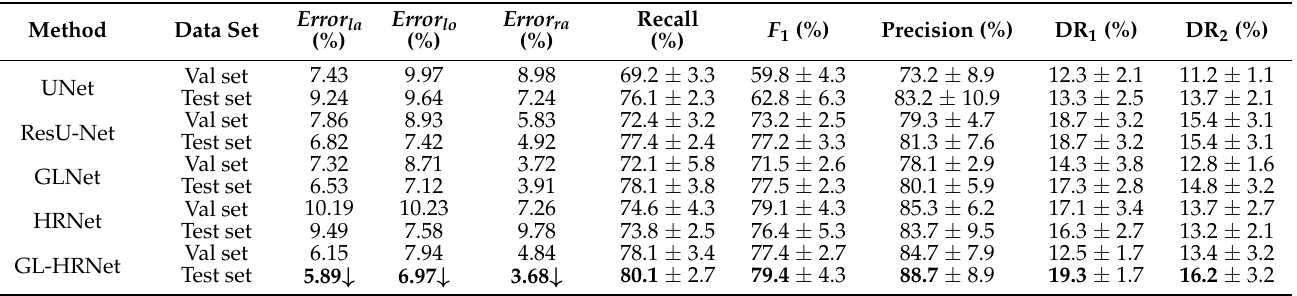
Table 3. The detection results of different network models on the validation data set and test data set. (Bold in the table indicates the best results of this evaluation index.)